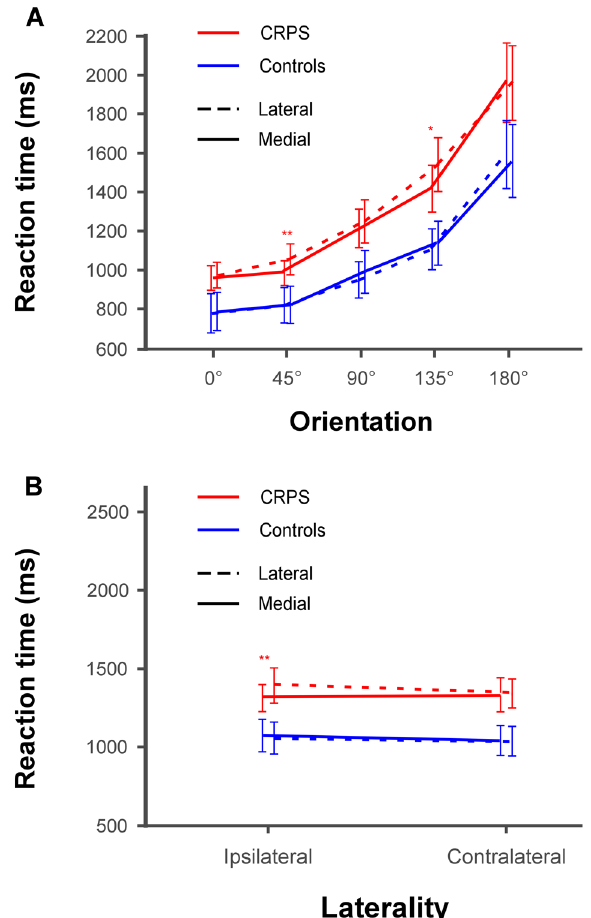
Figure 5. Mean RTs according to the group, the rotation and the orientation or laterality of the stimulus. ( A ) Illustration of the interaction between group, rotation and orientation. The lines represent the comparison of RTs between the lateral (dashed lines) and medial (plain lines) rotations for both CRPS (red) and control (blue) participants as a function of the orientation of the stimuli (i.e. 0° vs. 45° vs. 90° vs. 135° vs. 180°). ( B ) Illustration of the interaction between group, rotation and laterality. The lines represent the comparison of RTs between the lateral (dashed lines) and medial (plain lines) rotations for both CRPS (red) and control (blue) participants as a function of the laterality of the stimuli (i.e. ipsilateral vs. contralateral). Error bars represent the 95% confidence intervals adapted according to the method of Cousineau 69 . *p ≤ 0.05, **p ≤